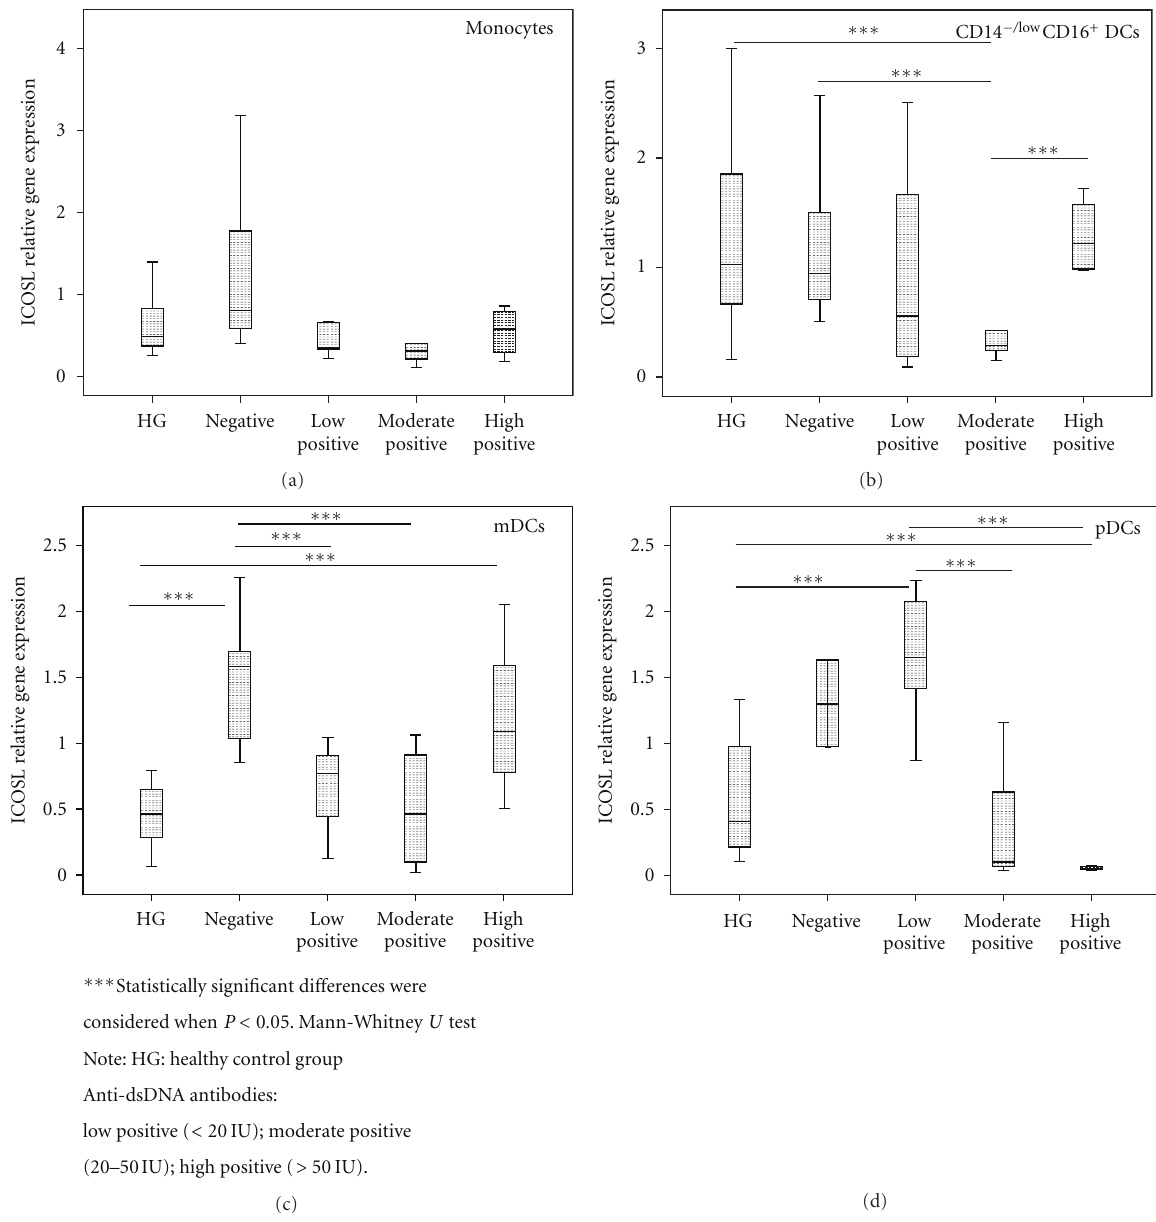
Figure 6: ICOSL relative gene expression in cell-sorted monocytes and DCs subsets, according to the amount of anti-dsDNA antibodies: negative; low, moderate, and high